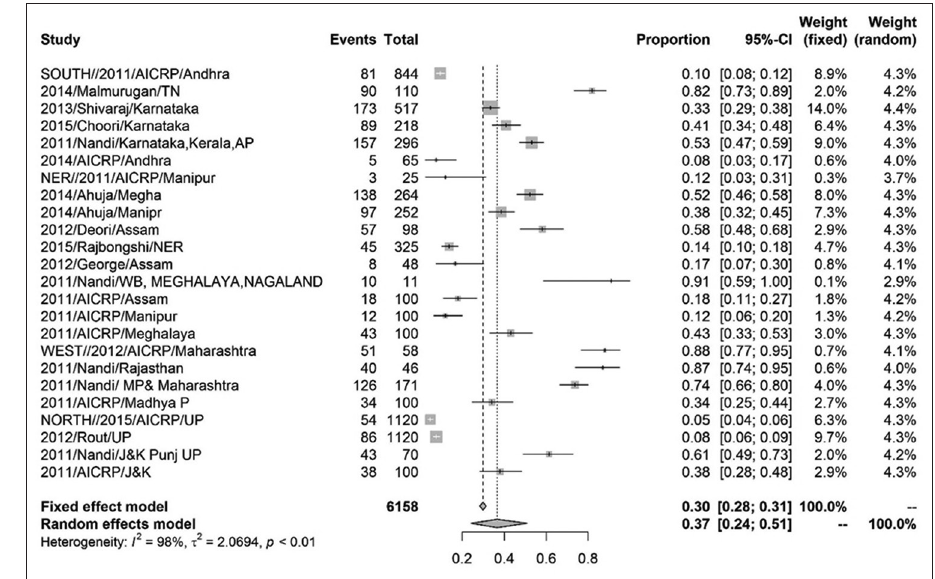
Figure-2: Forest plot of all Indian classical swine fever prevalence.